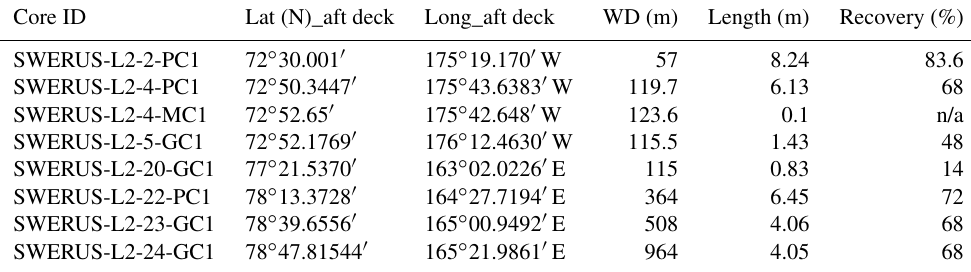
Table 1. SWERUS-C3 Leg 2 core